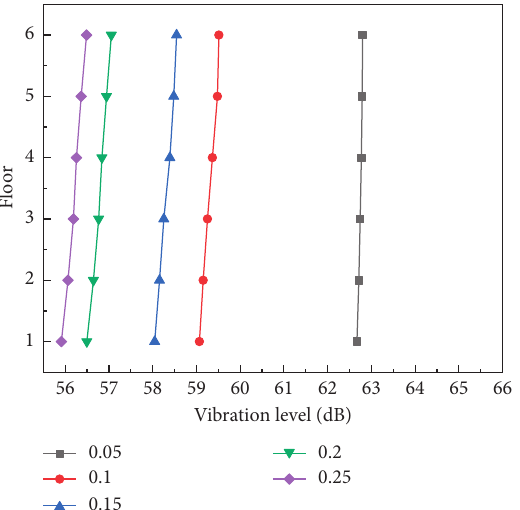
Figure 9: Variation curve of building vibration with floor under different damping